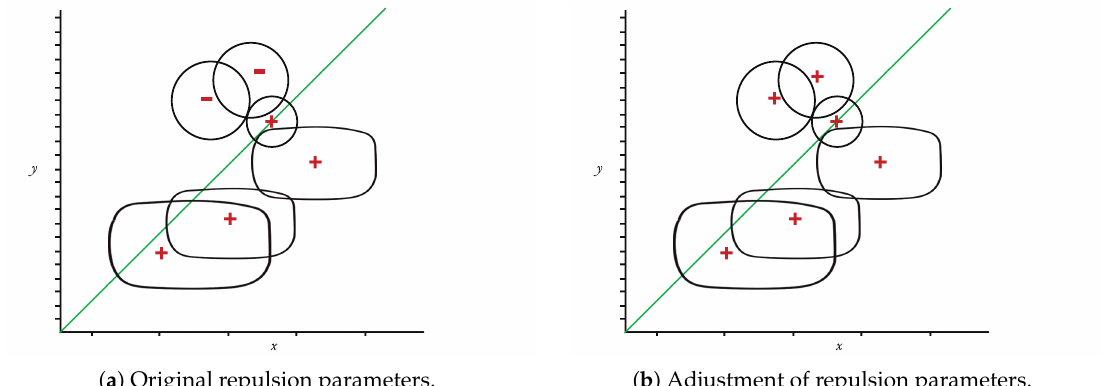
Figure 8. Correction of repulsion